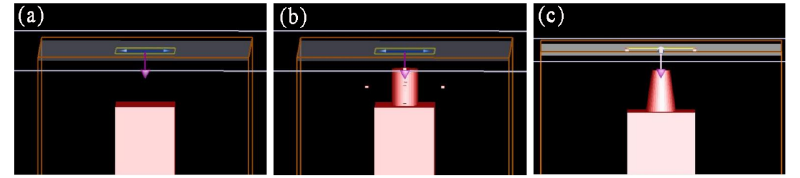
Figure 4. Simulation model of ( a ) planar silicon, ( b ) silicon nanopillars, and ( c ) Si NTCAs.